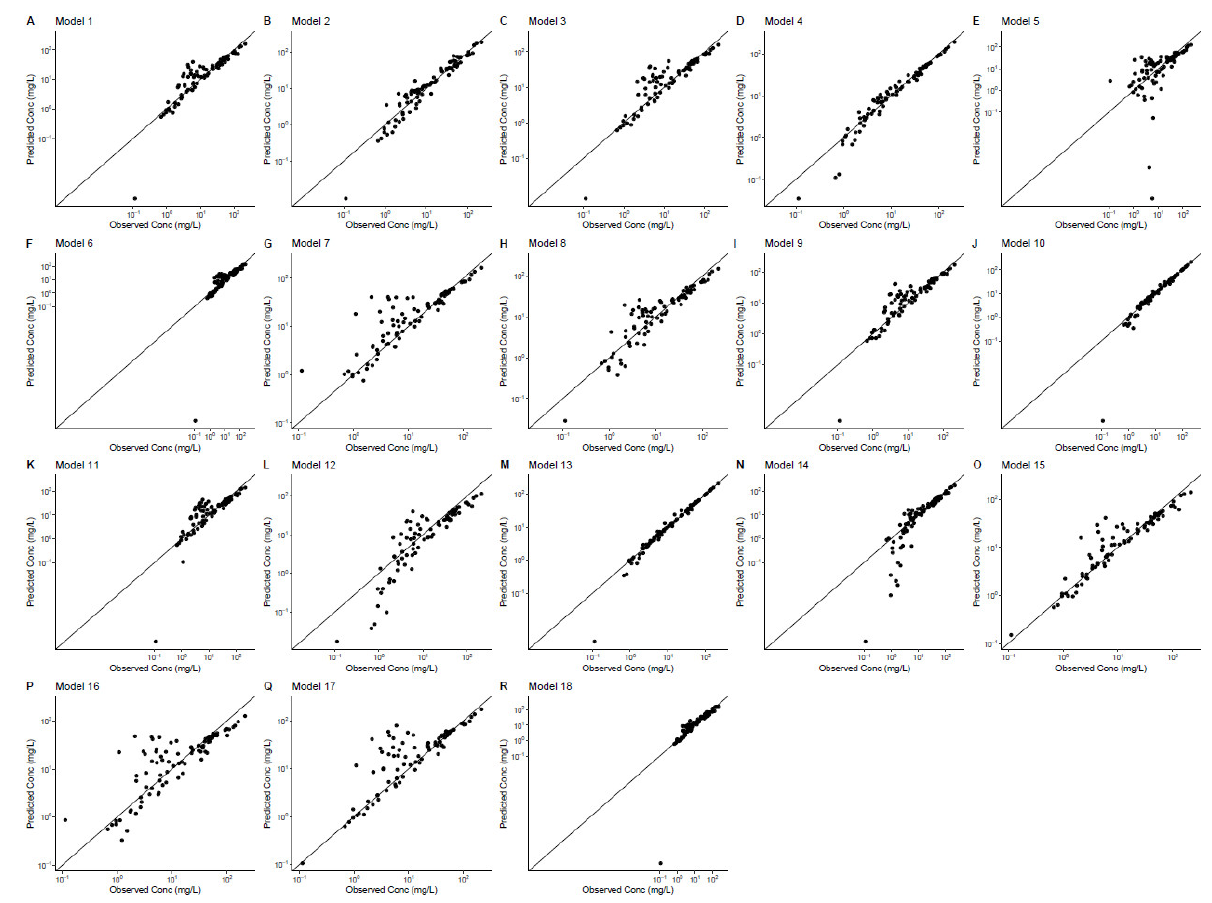
Figure 3. Individual predictive goodness-of-fit plots for eighteen models. Individual-predicted concentrations (y-axis) versus observed concentrations.